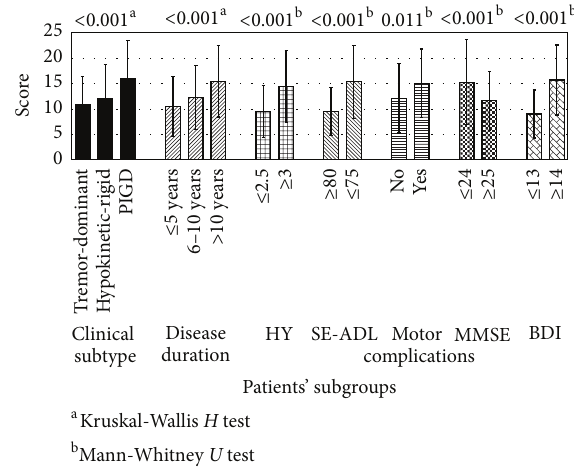
Figure 2: Bar diagram showing significant differences in mean scores of MDS-UPDRS Part I among subgroups of patients.